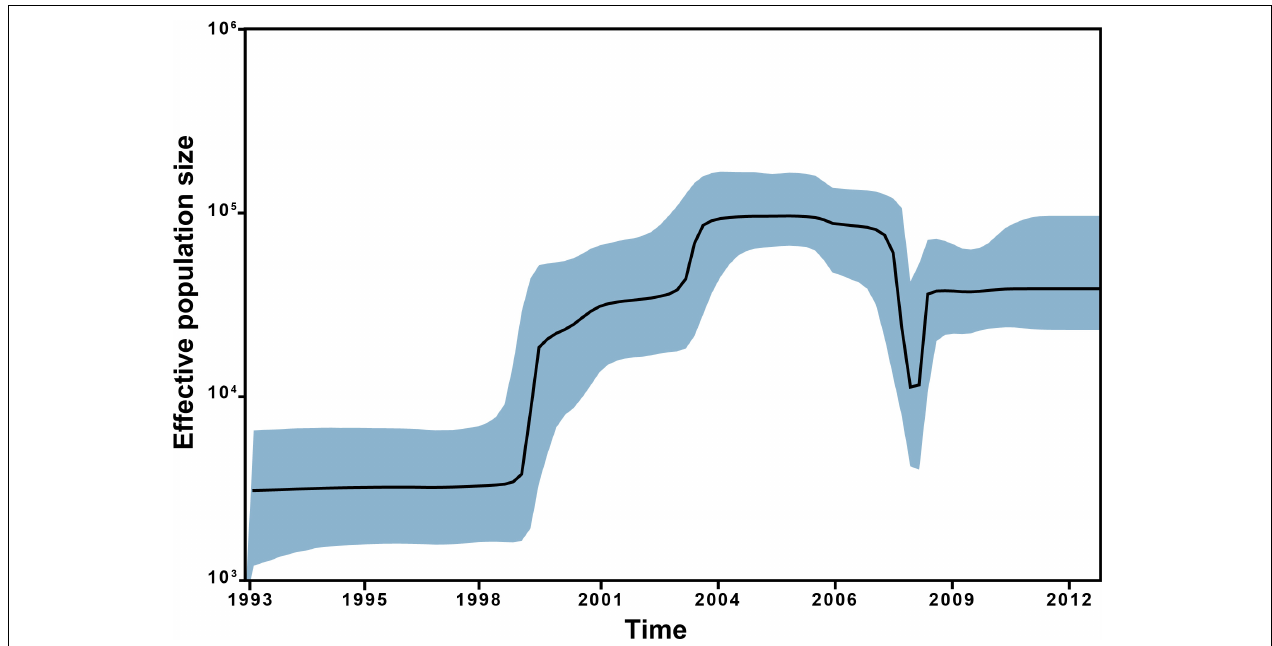
FIGURE 3 | Bayesian Skyline plot of the analyzed selected subset of 245 MRSA ST228 and ST111 MRSA genomes. Bayesian Skyline plot with a relaxed molecular clock representing the effective population size of the ST228 over time with the shaded areas representing 95% confidence